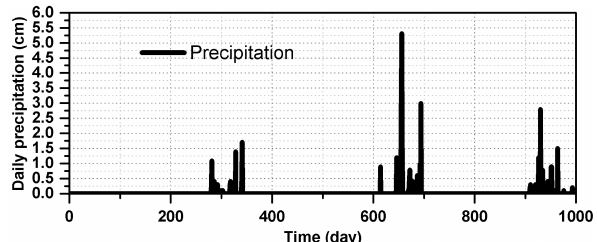
Figure 2. The record of daily rainfall sums from Riyadh city that was used in the numerical scenario study. Three rainfall clusters are visible. The largest daily rainfall amount (5.4cm) fell on day 656. The observation period starts on 4 June 1993, and ends on 27 February